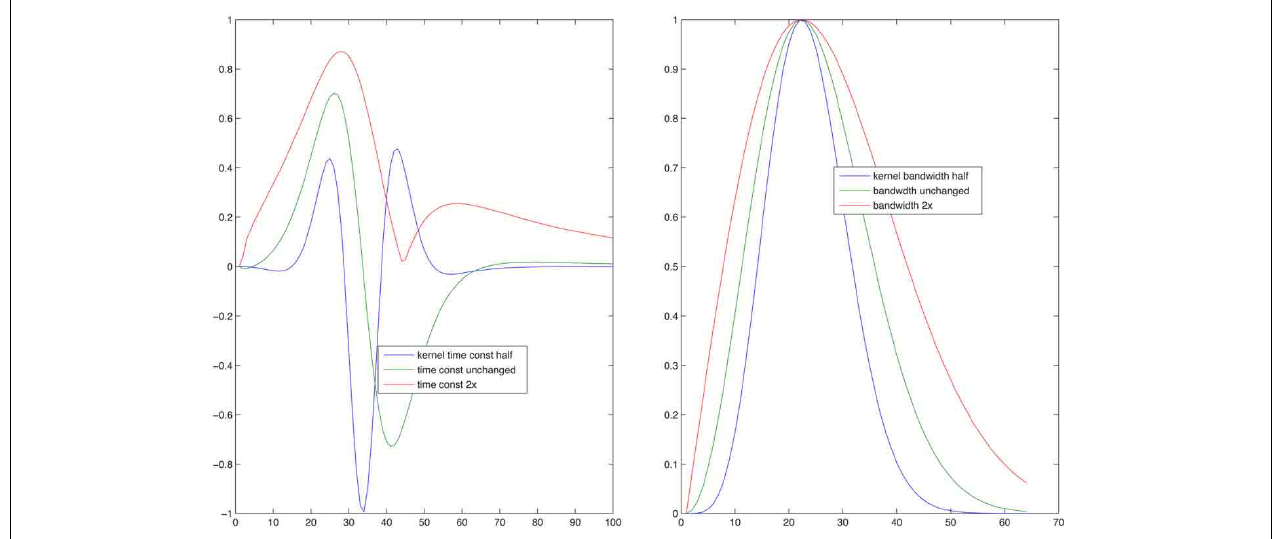
FIGURE 5 | Kernel functions used by the model of Chi et al. (2005) to generate temporal (left) and spectral (right) modulation planes at any given temporal rate and spectral scale specified. The line in the center of each of the three shown in the two panels is the unmodified kernel function andwasusedtosimulateresultsoftheyoungsubjects.Inbothpanelsthelines